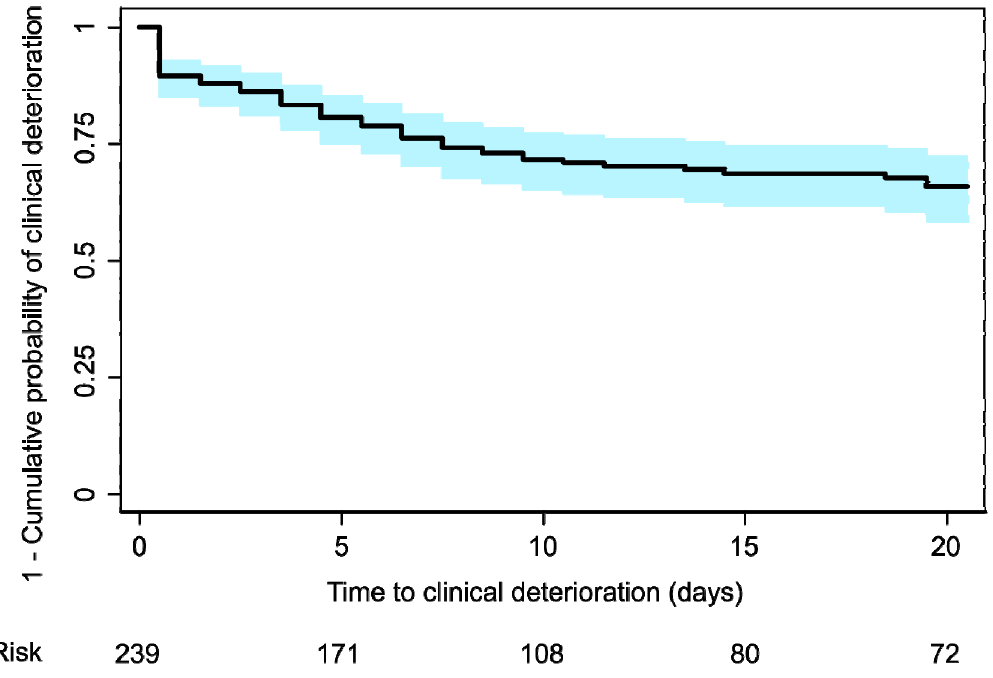
Figure 1. Kaplan–Meier curve in patients with confirmed COVID-19 admitted to Humanitas Research Hospital, between 22 February to 22 March 2020. The composite endpoint was ICU transfer or death. The overall 20-day event-free survival was 0.66 (95% CI, 0.59–0.72). CI: confidence interval; ICU: intensive care unit.